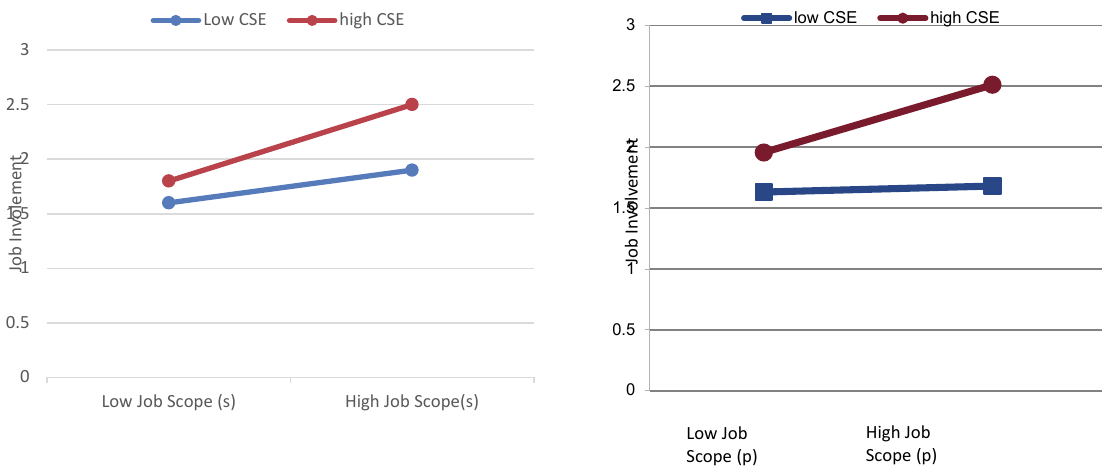
Fig. 1. (a) Visual representation of the interactional effects Fig. 1. (b) Visual representation of the interactional